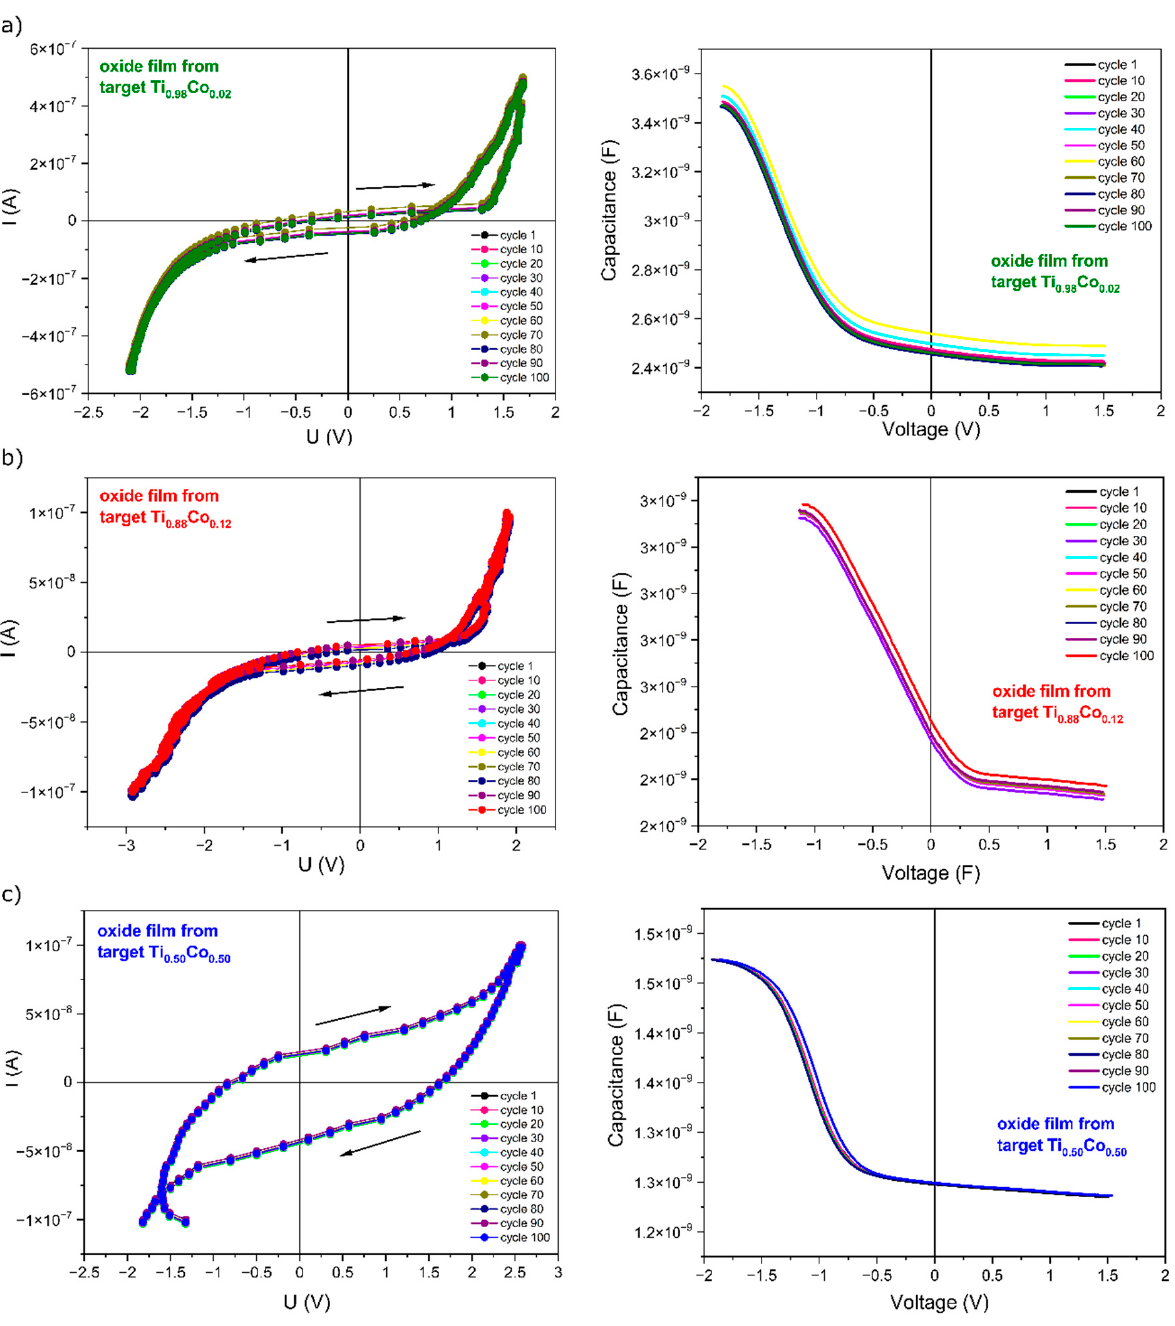
Figure 13. Current to voltage (I–V) and capacitance to voltage (C–V) characteristics of prepared Au/(Ti,Co)Ox/Si structures with different cobalt concentration—prepared from: ( a ) Ti 0.98 Co 0.02 , ( b ) Ti 0.88 Co 0.12 , ( c ) Ti 0.50 Co 0.50 targets.